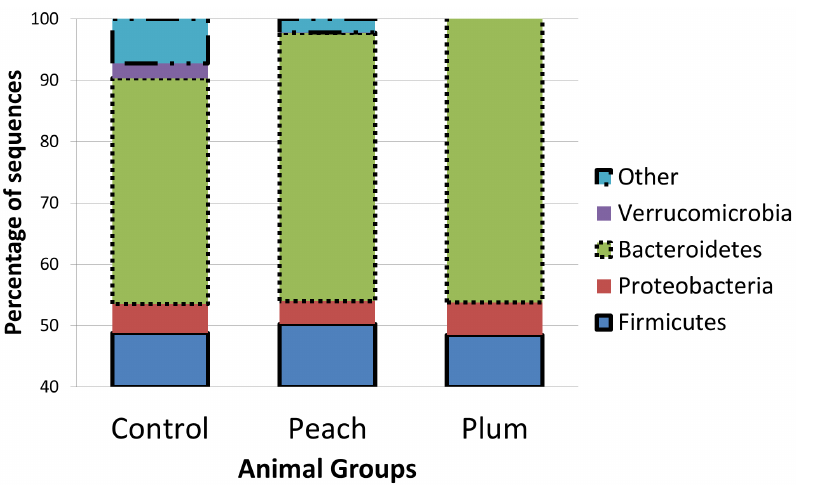
Figure 2. Composition of fecal microbiota in the control (n=4), peach (n=4) and plum (n=4) groups at the phylum level. Bars represent median percentage of sequences. The y axis (percentage of sequences) was modified to also show the low abundant phyla.